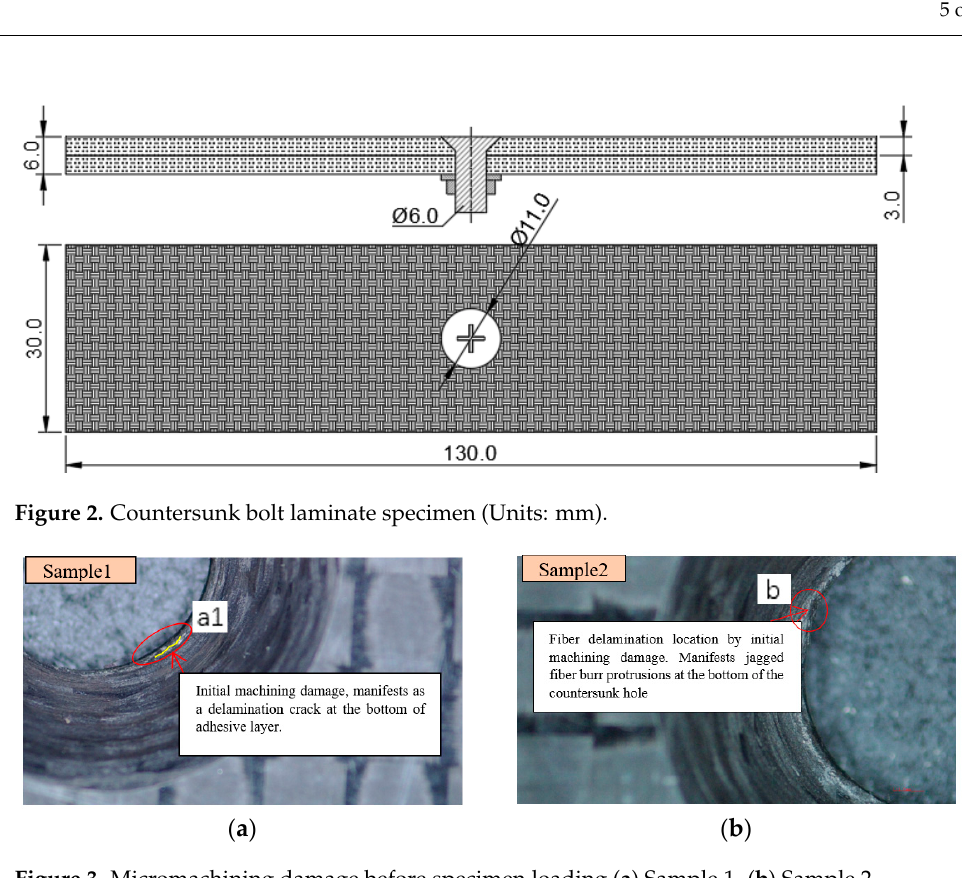
Figure 3. Micromachining damage before specimen loading.( a ) Sample 1. ( b ) Sample